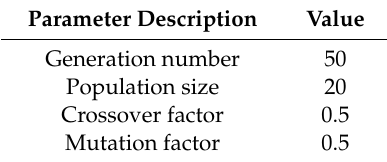
Table 2. The di ff erential evolution optimization (DEO) algorithm parameter settings.